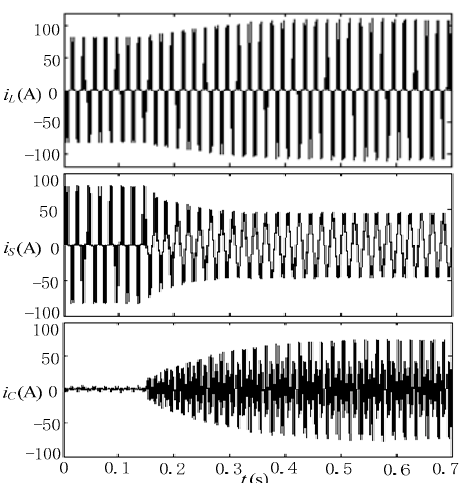
Figure 11. Dynamic waveform during APF compensation.